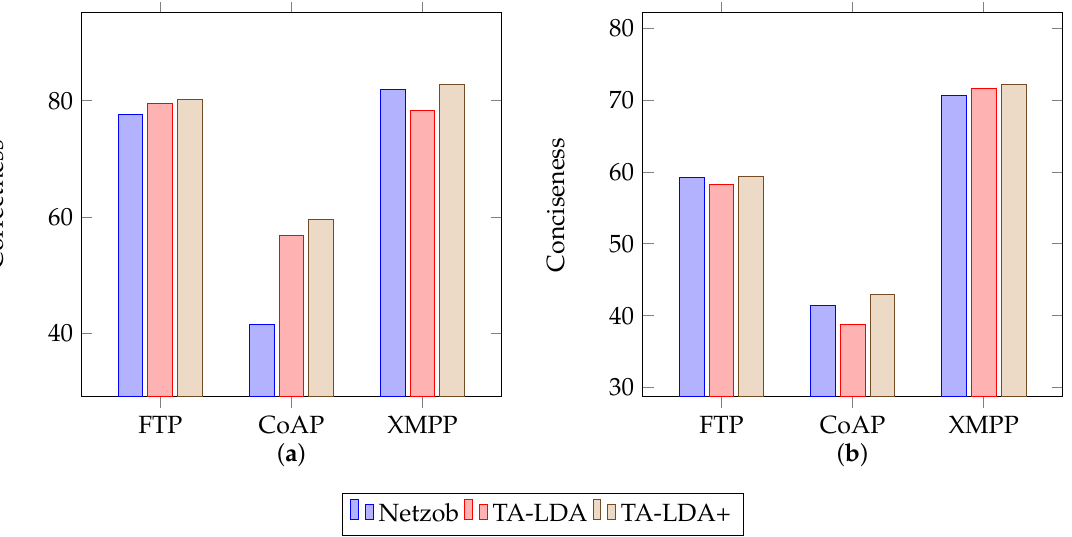
Figure 7. Correctness and Conciseness Comparison. ( a ) Correctness for different approaches applied to infer message formats; ( b ) Conciseness for different approaches applied to infer message